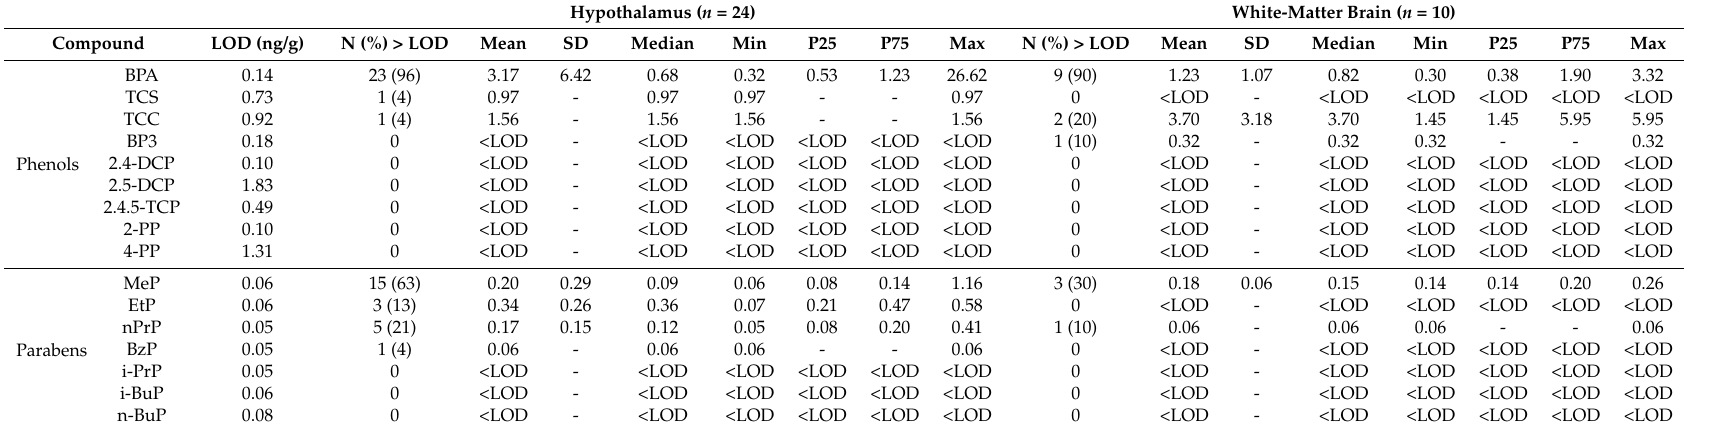
Table 1. Phenols and parabens (ng/g) in hypothalamus and white-matter brain